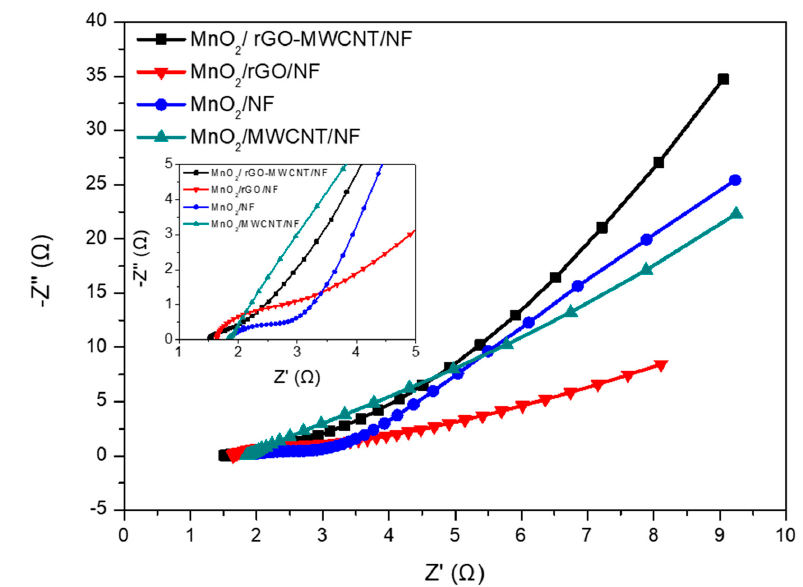
Figure 7. Electrochemical impedance spectra (EIS) analysis of the as-deposited electrodes in the frequency range from 100 kHz to 0.01 Hz.